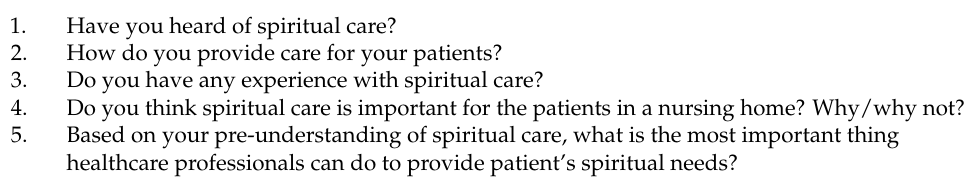
Table 1. Example questions for focus group and individual